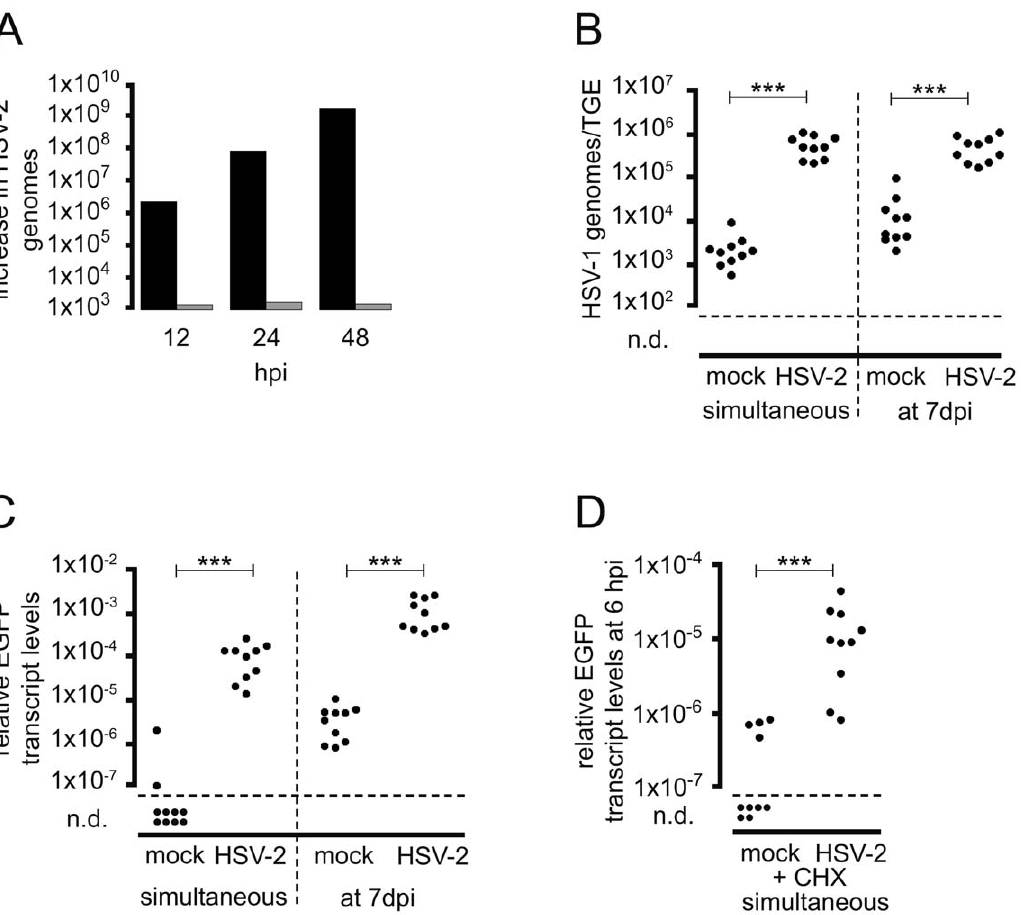
Figure 7. Transcriptional transactivation of HSV-1 IE gene expression by HSV-2 helper virus. (A) Replication of HSV-2 in TGEs. Groups of three TGEs were either infected in the AC with 5 6 10 6 pfu of HSV-2 333 (grey bars) or in the GC with 10 4 pfu of HSV-2 333 (black bars), and harvested at the time points indicated. DNA extracts were pooled, genome levels were determined by qPCR, and the increase in genome levels relative to 1 hpi was calculated. (B, C) Transactivation of HSV-1 by HSV-2 infection of the GC. TGEs were infected in the AC with 5 6 10 6 pfu of HSV-1 CMV-IEproEGFP, and infected either simultaneously or at 7 dpi in the GC with 5 6 10 6 pfu of HSV-2 333. Cultures were harvested at 24 hpi after the addition of HSV-2 to the GC, and HSV-1 genome (B) and relative EGFP transcript levels (C) were determined. Cultures not infected with helper virus served as controls. The statistical significances of differences in the transcript levels are indicated (simultaneous infection, P , 0.0001; addition of PrV at 7 dpi, P , 0.0001; Mann-Whitney test). (D) Transcriptional transactivation of HSV-1 by co-infection of the GC with HSV-2 in the presence of CHX. TGEs were infected in the AC with 5 6 10 6 pfu of HSV-1 17 IE4proEGFP in the presence of CHX and either co-infected in the GC with 5 6 10 6 pfu of HSV-2 333 or mock- treated. Cultures were harvested at 6 hpi and EGFP transcript levels normalized to b -actin transcripts were determined. The statistical significances of differences in the mean relative transcript levels are indicated ( P . 0.0001, unpaired t-test with Welch correction).